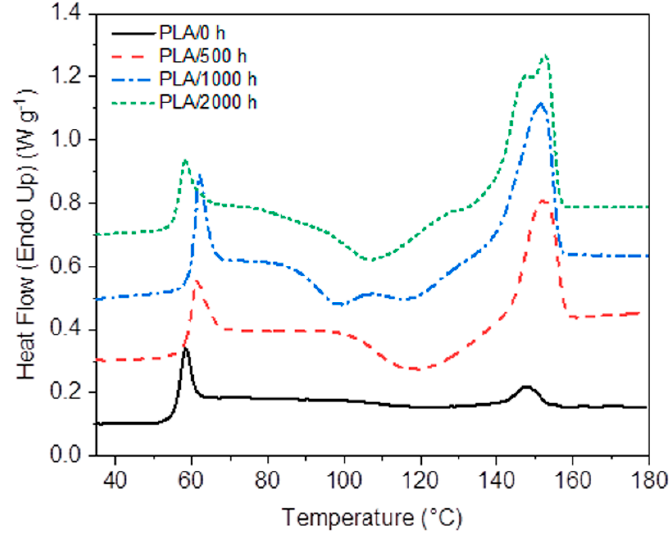
Figure 11. DSC first heating curves of neat PLA after accelerated weathering degradation.